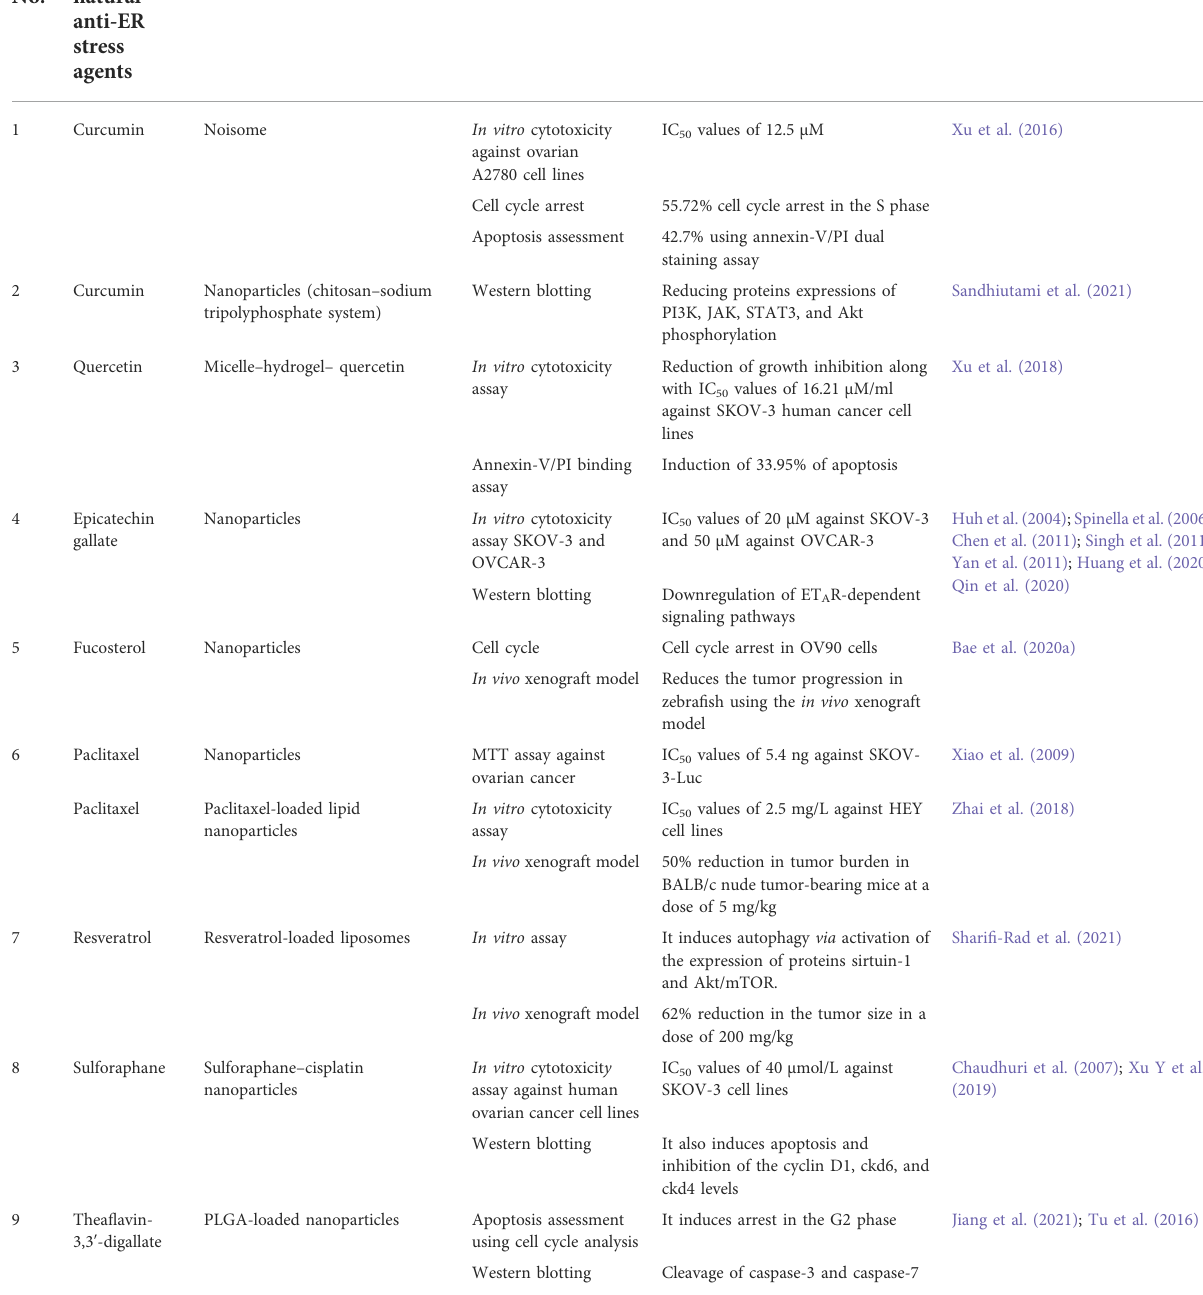
TABLE 1 Summary of some anti-ovarian phytomolecules and their nanosystems. S.